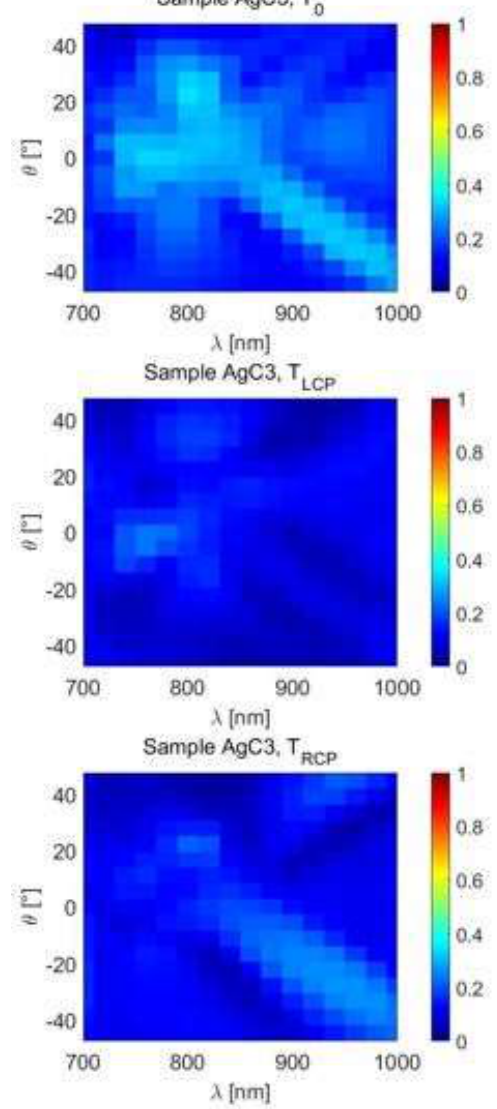
Fig. 2 Circular polarization resolved response of the sample when it is excited with linearly polarized laser beam, widely tunable in wavelength and angle of incidence. T 0 , T LCP , and T RCP denote the output QWP angle of 0°, -45° and +45°,